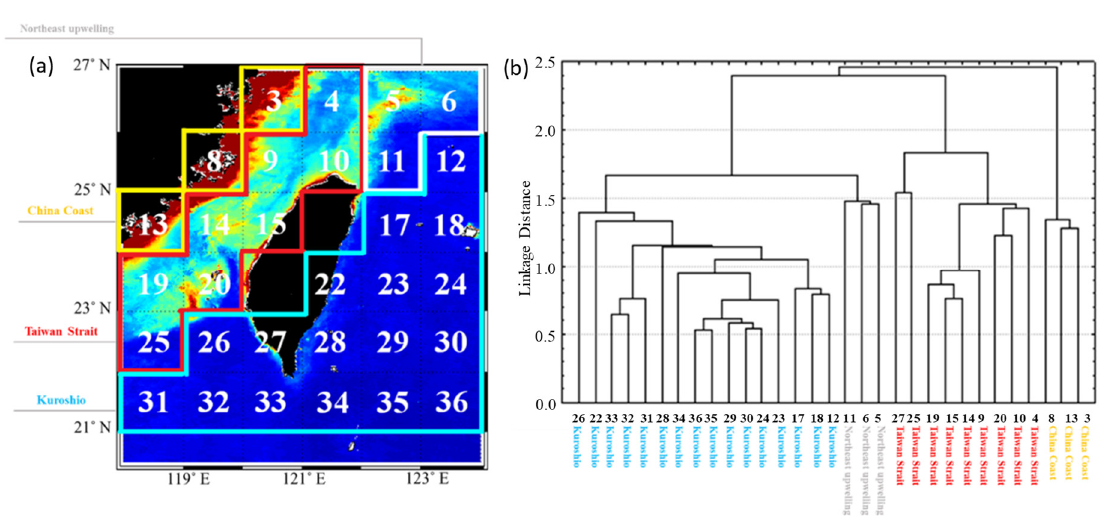
Figure 2. ( a ) The waters around Taiwan were divided into 1° gridded areas for 36 sites. The subareas for the China Coast water, Taiwan Strait water, Northeastern upwelling water, and Kuroshio water were divided by the cluster tree diagram results using the monthly Chl-a, SST, and PAR during study period (2009–2013) in ( b ). The monthly mean PP A&T image in 2009 was used as an example in ( a ).